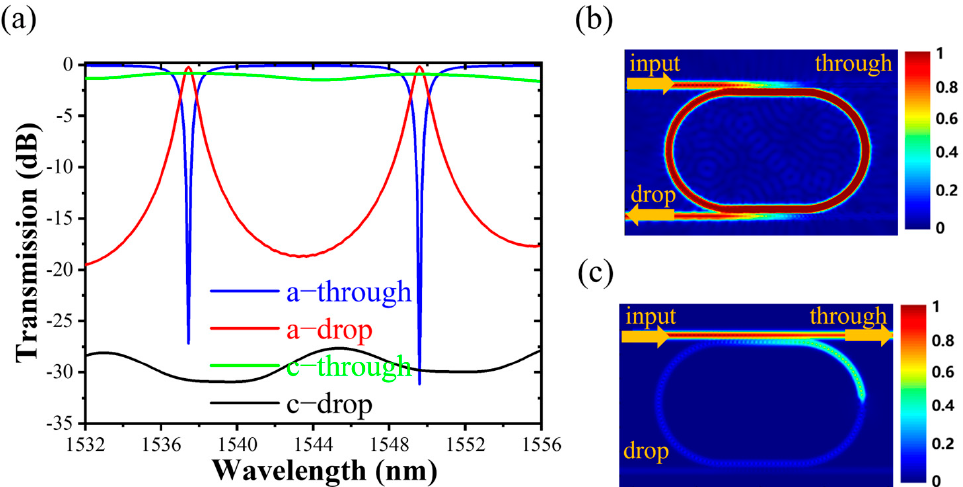
Figure 4. ( a ) Spectral responses at the through and drop ports of the device. The normalized electric field distributions of GSST in ( b ) amorphous and ( c ) crystalline states ( λ res = 1549.6 nm).